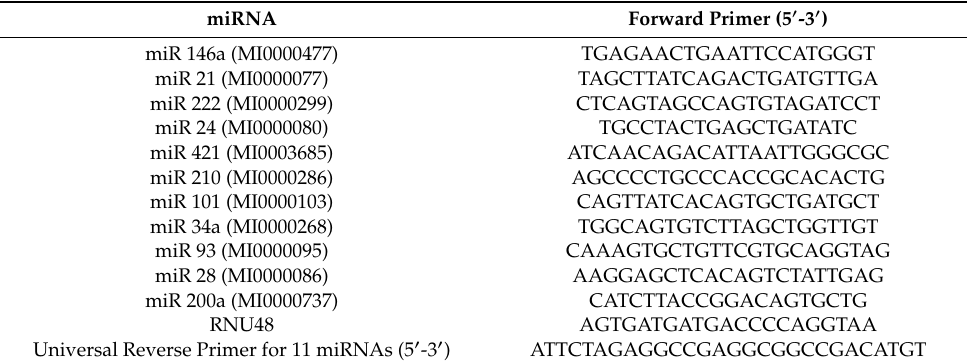
Table 1. qRT-PCR primers for miRNAs.